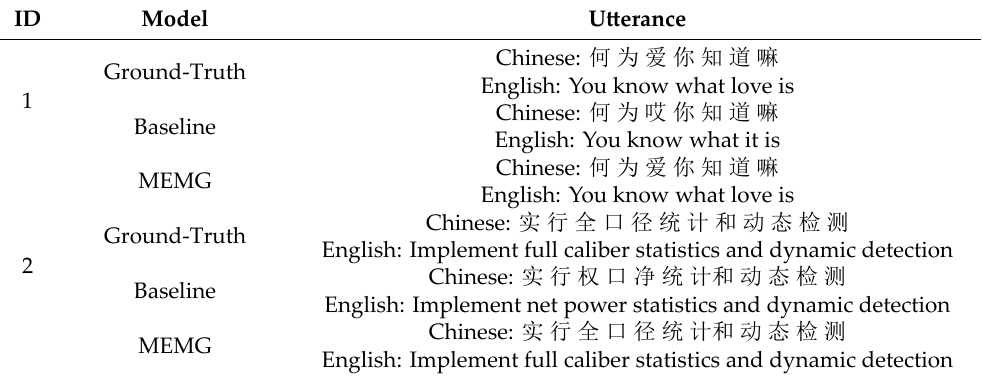
Table 7. The examples of two test